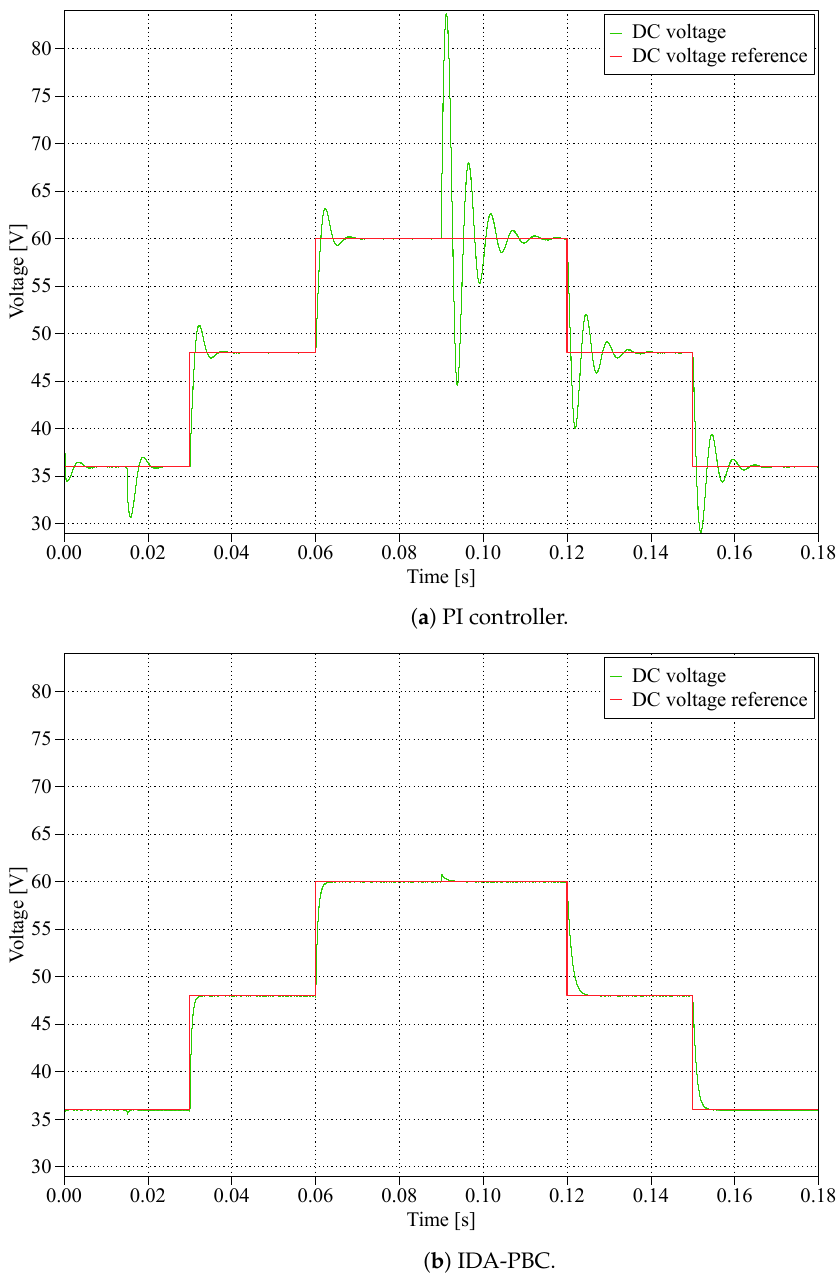
Figure 8. The dynamic response of output voltage of the interleaved boost converter under different DC voltage and current